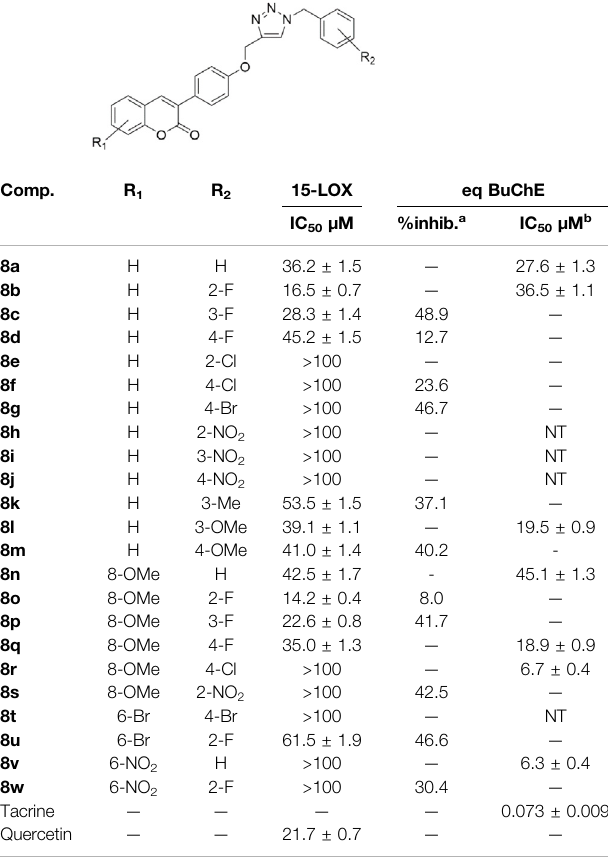
TABLE 1 | AChE, BuChE, and 15-LOX inhibitory activity of the synthesized compound 8a - 8w .